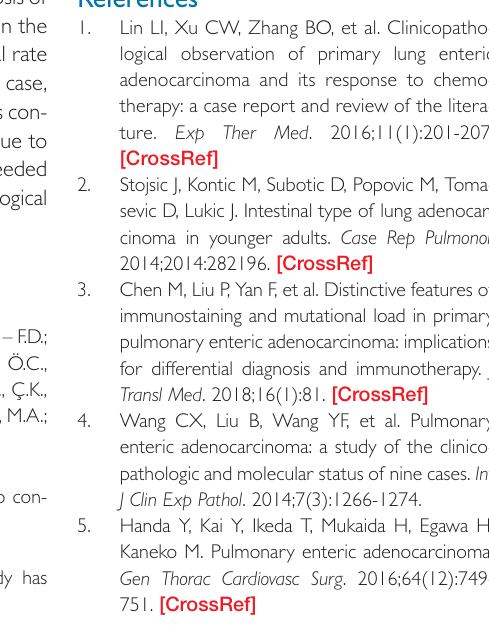
“Pulmonary enteric